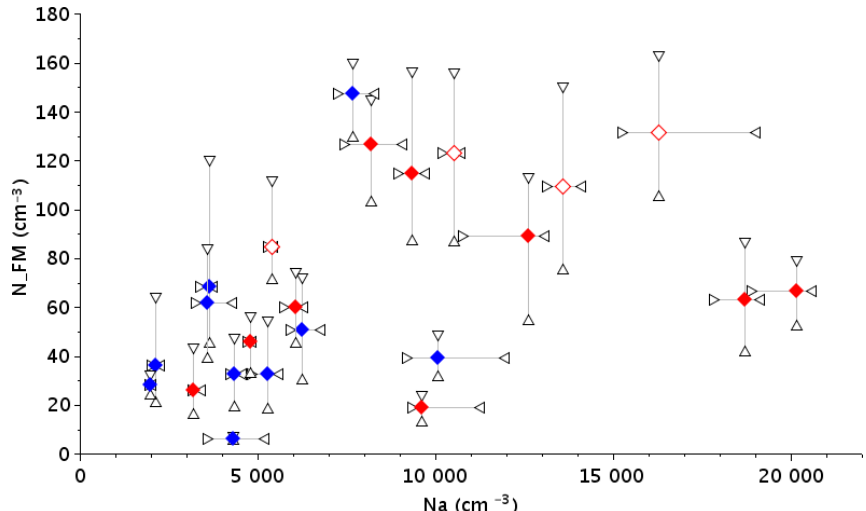
Figure 2. Droplet number concentration as derived from the FM-100 collected during the whole fog event as a function of the aerosol number concentration as derived from the SMPS measurements collected over the last hour before the fog beginning. Median values (diamonds) are indicated for each case of Table 2, with the 25th and 75th percentiles (triangles) to represent the variability. Symbols depend on the fog types, STL (blue) and RAD (red), with open and solid symbols for thin and developed fogs,